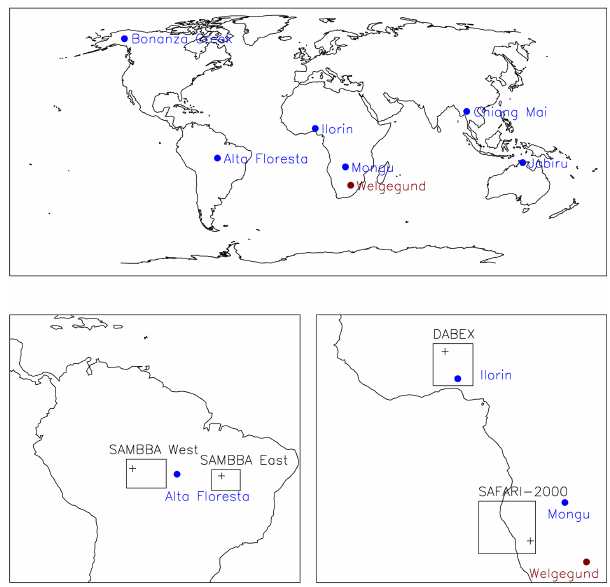
Figure 1. Maps showing the location of AERONET sites (blue), the Welgegund ground station, and the averaging boxes used cor- responding to the flight regions from SAMBBA (West and East), DABEX, and SAFARI-2000. Plus symbols indicate the locations of the main airbases used for the flights: Porto Velho for SAMBBA West, Palmas for SAMBBA East, Niamey for DABEX, and Wind- hoek for